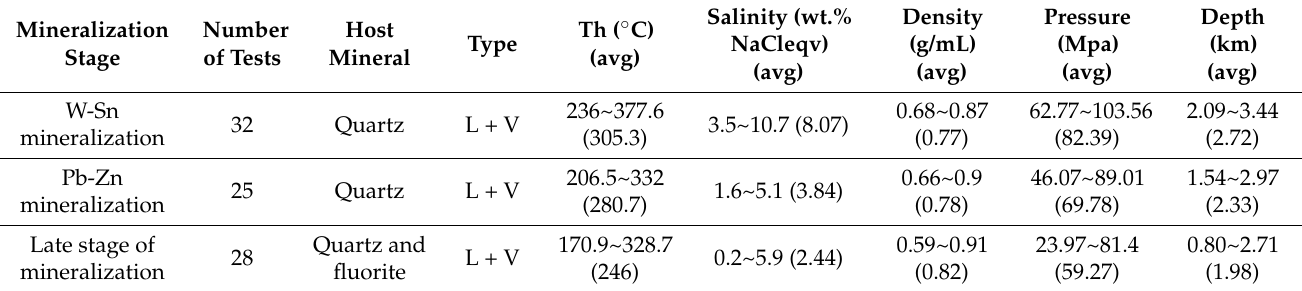
Table 2. Fluid inclusion data of the Hongqiling Sn-W polymetallic